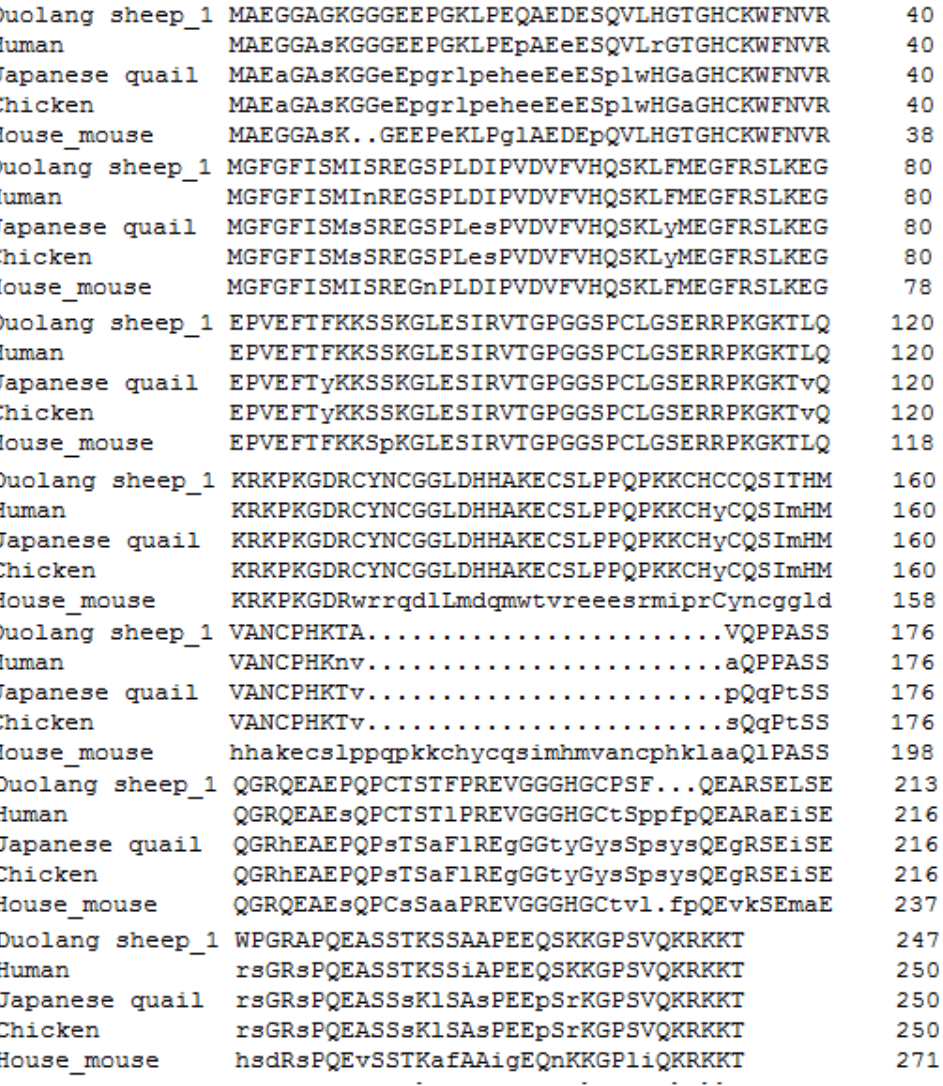
Figure 2. Alignment of the amino acid sequences of the predicted Duolang sheep lin-28 homolog B protein with those of human (AAZ38897.1), Japanese quail (XP_015714194), house mouse (AAZ38894.1), and chicken (AAZ38896.1).